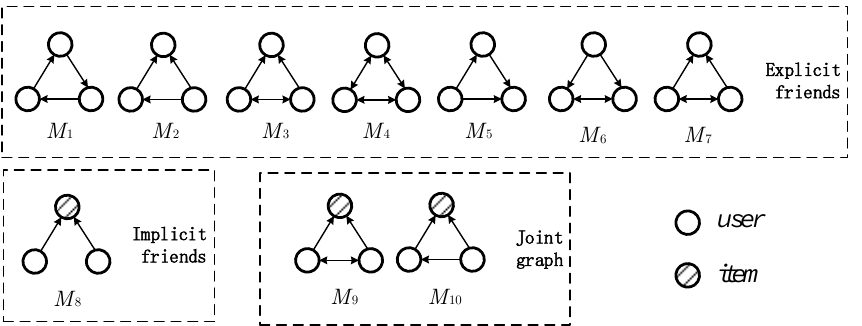
Figure 1. Directed triangle pattern theme for a social network. When given any motif set